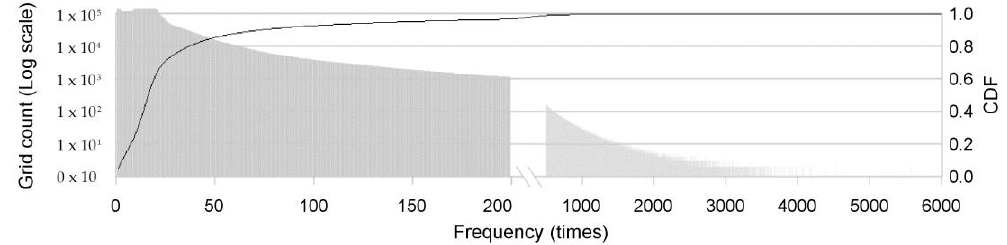
Figure 9. Distribution by ship frequency in Korean coastal waters.